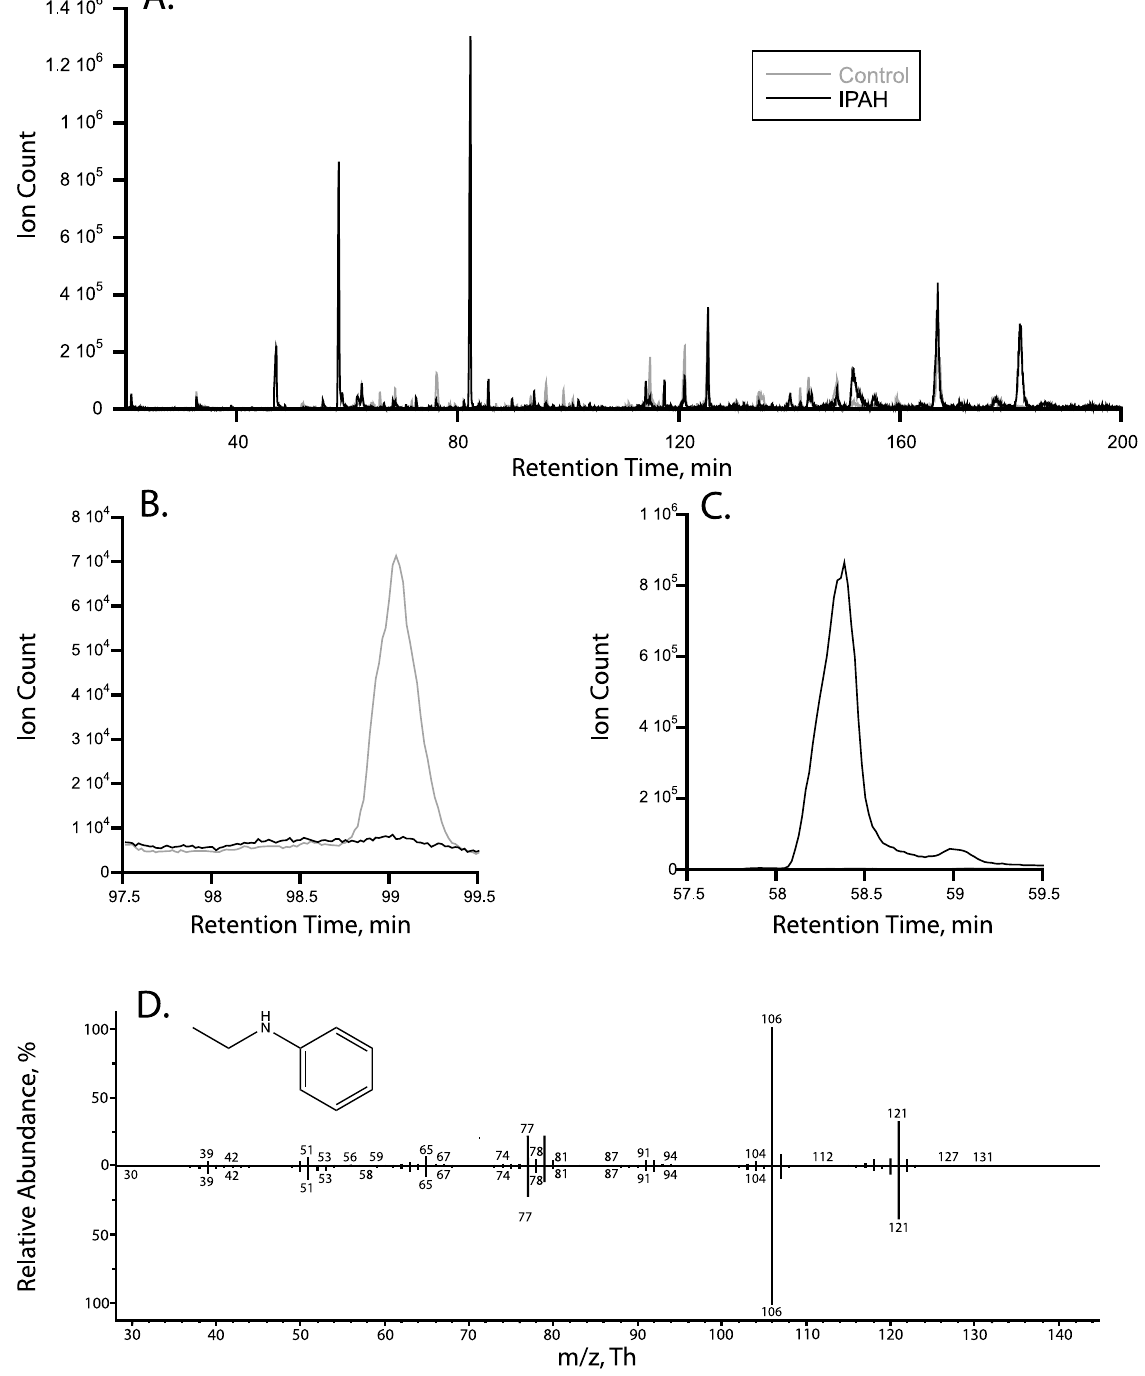
Figure 1. Representative gas chromatograms from a control subject (black line) and IPAH subject (grey line) (A) showing significantly different ( p # 0.05) unique peaks for the control subject (B) and IPAH subject (C). An example of a head-to-tail comparison of an experimental mass spectrum (D) of one of the identified significantly different peaks unique for the IPAH group at a retention time of 81.436 min. (top) with a NIST/Wiley 2009 database search hit (bottom) identifying N-ethyl-Benzeneamine as giving the best match for the experimental spectrum. IPAH [18]. In the current study the EBC metabolic signature was present in control subjects’ gas chromatograms. In addition, AR/ discriminatory in delineating severe IPAH subjects from age- PLSR analysis conserves these distinguishing features while greatly matched controls. This in large part was due to the 48 peaks only reducing the dimensionality of the data. This metabolomic present in IPAH subjects’ gas chromatograms, and 62 peaks only approach provides a means to compare the complex information